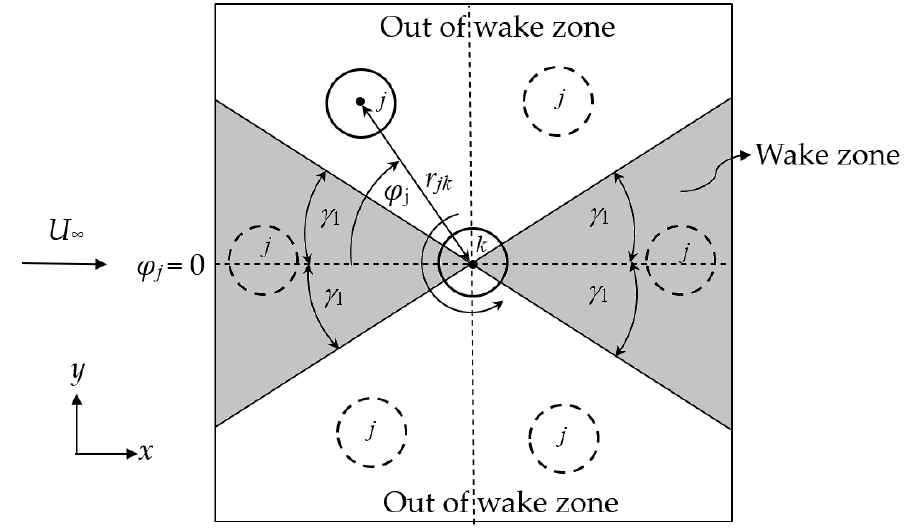
Figure 4. Definitions of the angle 𝜑 (cid:3037) of the selected two rotors and the wake